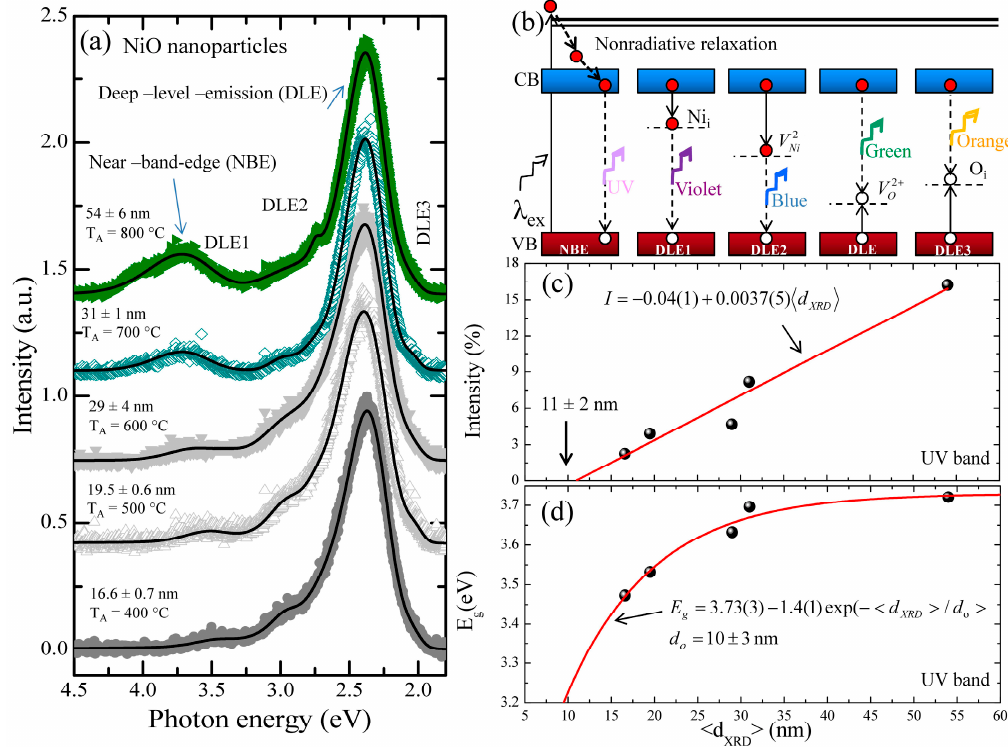
Figure 4. ( a ) Crystallite size dependency of room-temperature PL spectra, revealing narrow band gap emission extending from the UV to the visible region, where the solid line represents fitted PL spectra using Voigt function; ( b ) demonstrating various PL emission components that originated due to electronic transition between different defect levels and band edge of NiO nanoparticles. Crystallite nanoparticle size dependencies of ( c ) intensity of UV emission ( d ) band gap energy E g . The solid lines represent a linear fit to the intensity data and an exponential fit to the emission energy, respectively.